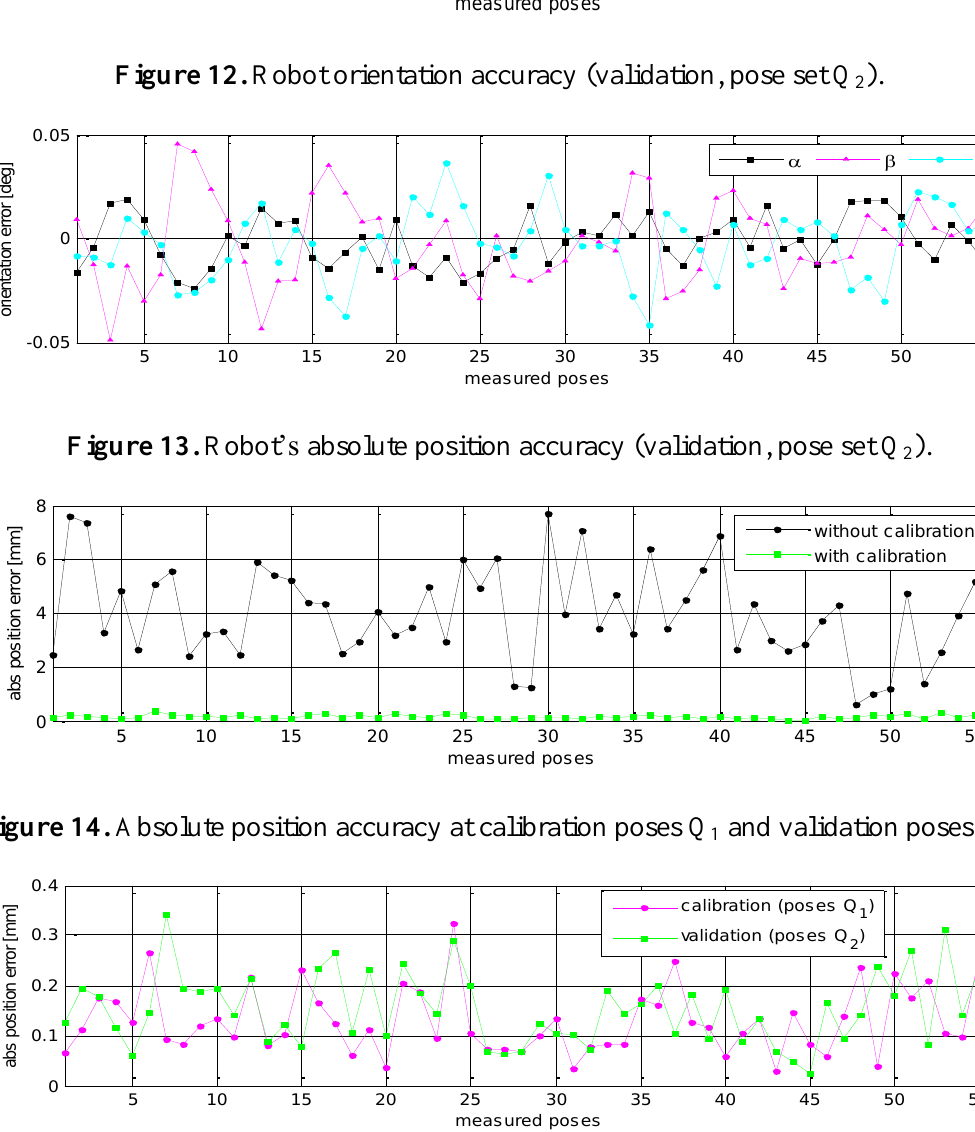
Figure 12. Robot orientation accuracy (validation, pose set Q